Question: Write a single sentence explaining what this figure depicts.
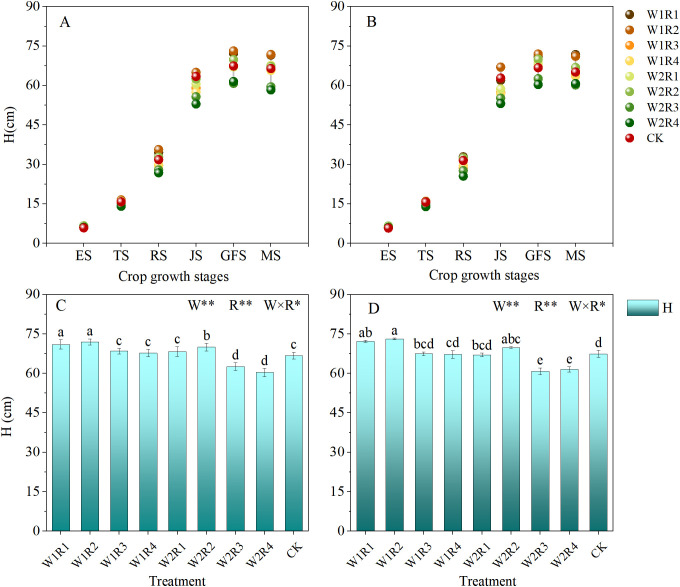
Answer: Changes in winter wheat plant height during the growing seasons in 2023-2025. (A, B) show changes in plant height as the growing season progressed in 2023–2024 and 2024-2025, respectively. (C, D) show bar charts of the analysis of variance (ANOVA) for plant height during the grain-filling stage in 2023–2024 and 2024-2025, respectively; Lowercase letters indicate significant differences among treatments (p< 0.05); W, real-time irrigation level; R, fertilizer-pesticide treatment; *p< 0.05, **p< 0.01.